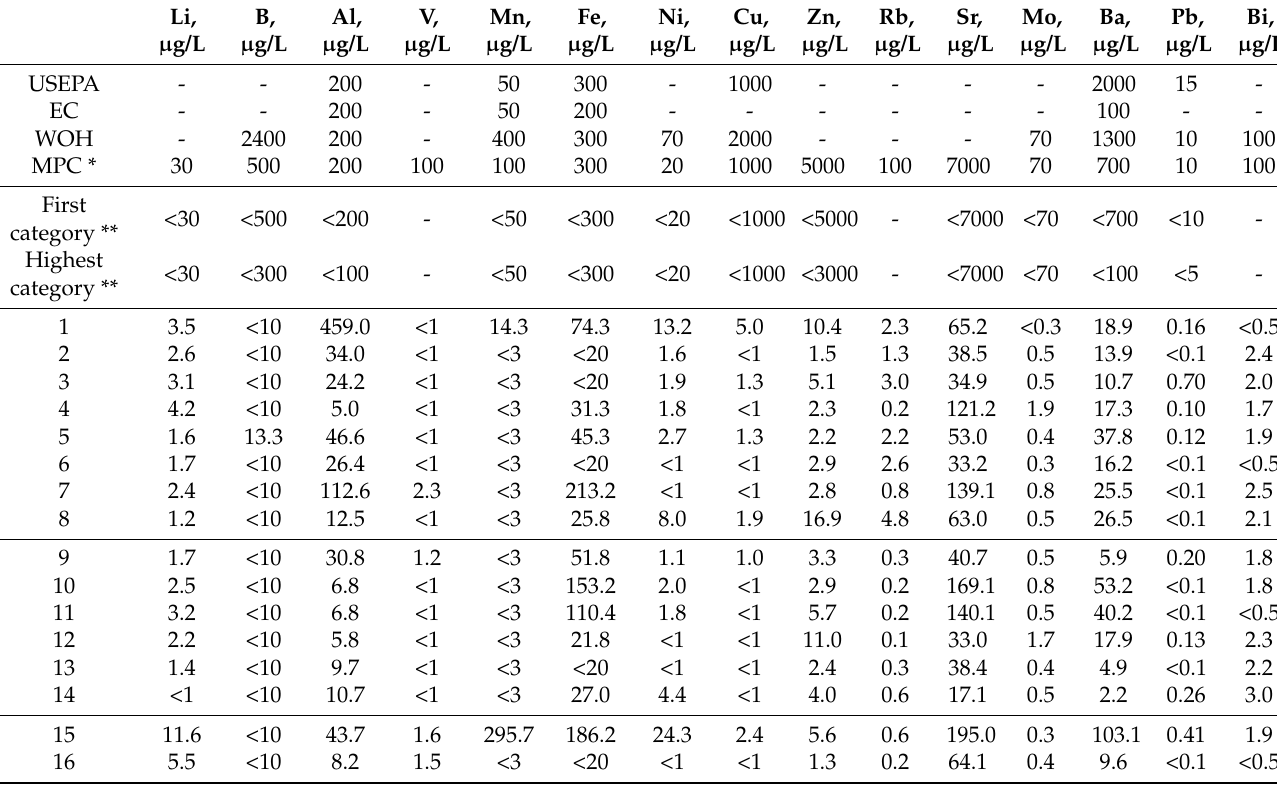
Table 4. Content of microelements in spring